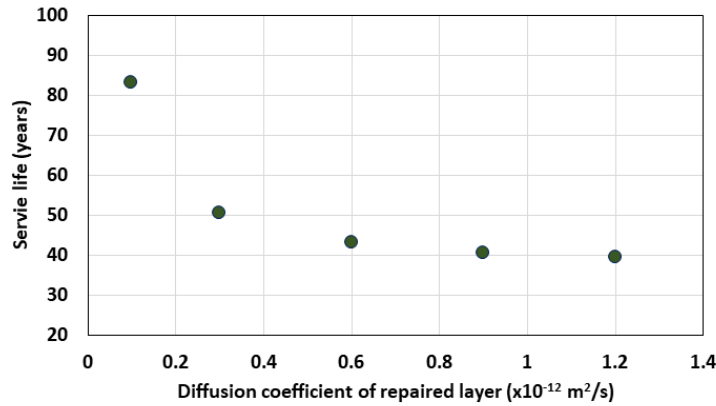
Figure 11. Service life variation with diffusion coefficient in slime coating.